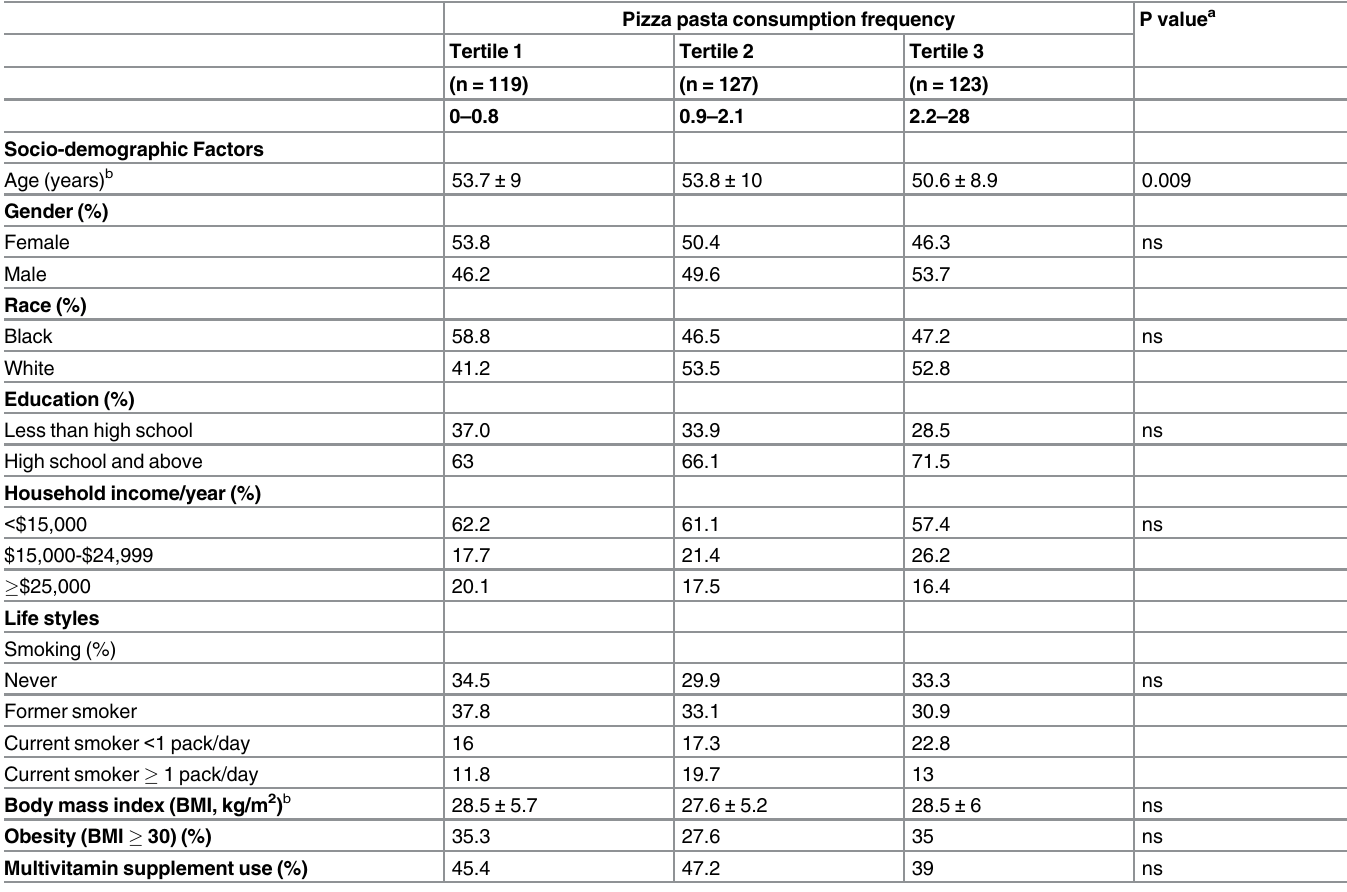
Table 1. Population characteristics of study participants (n = 369) across the pizza and pasta consumption frequency